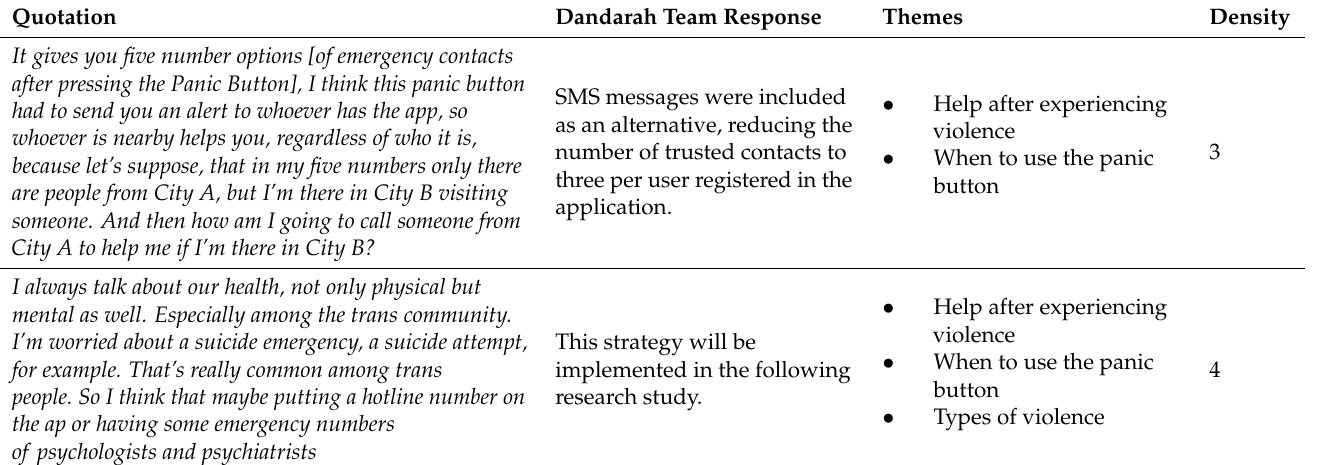
Table 1. SGM suggestions to improve the Rainbow Resistance: Dandarah